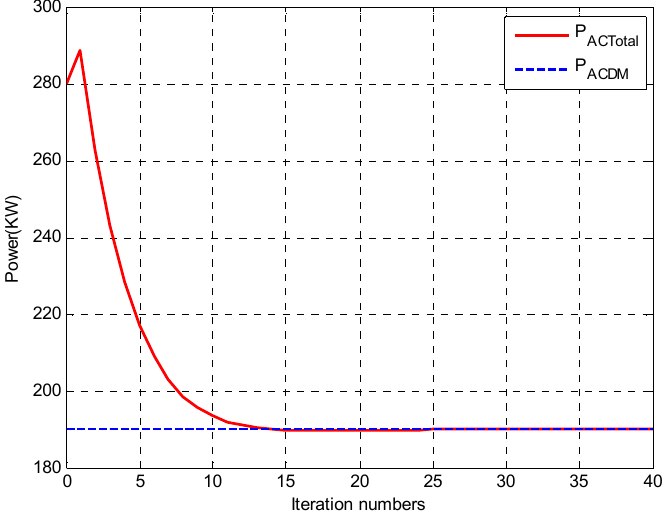
Figure 8. Power mismatch of a single period in the DC sub-grid.